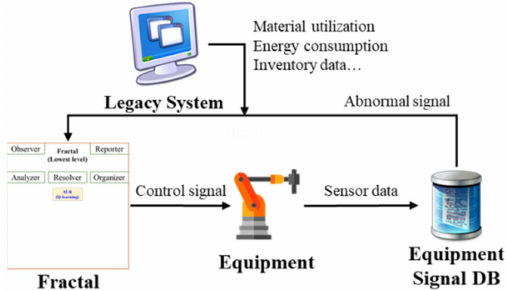
Figure 7. Self-regulation characteristic for SSrMS.